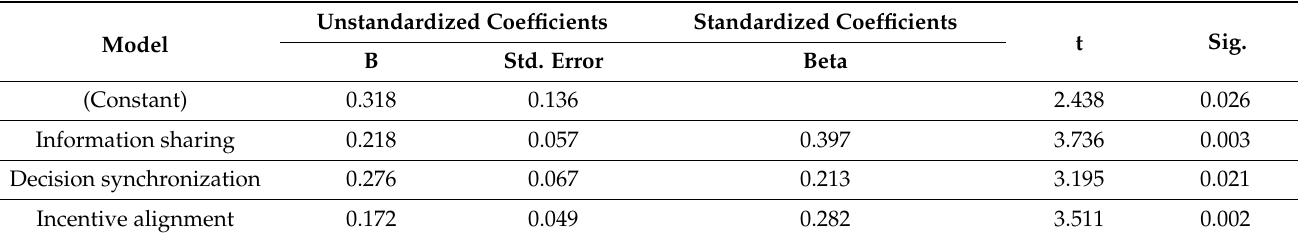
Table 7. Regression